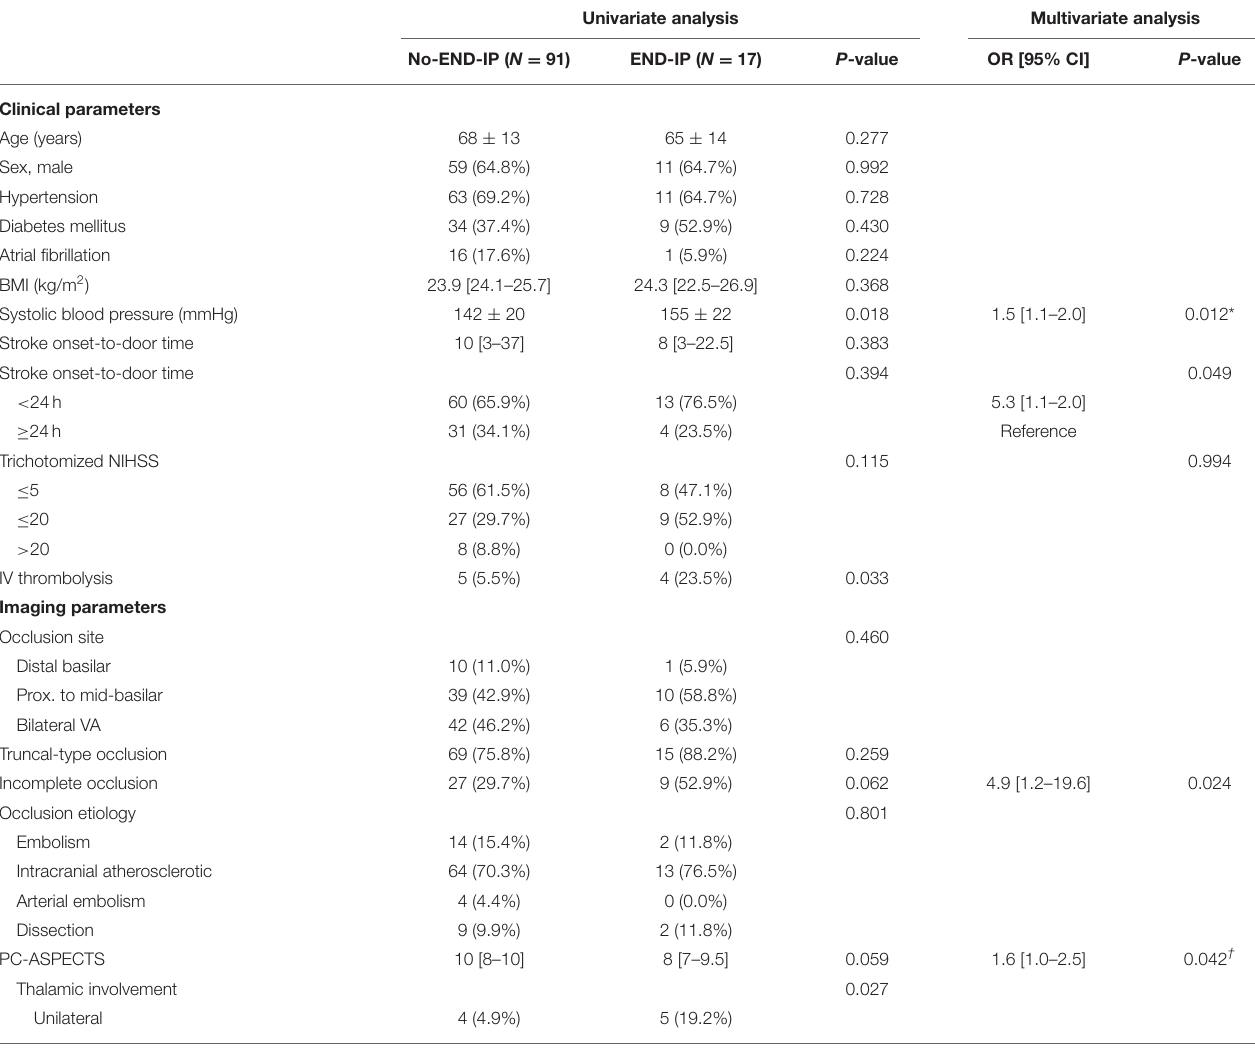
TABLE 3 | Prediction of END due to ischemia progression in vertebrobasilar artery occlusive stroke patients managed